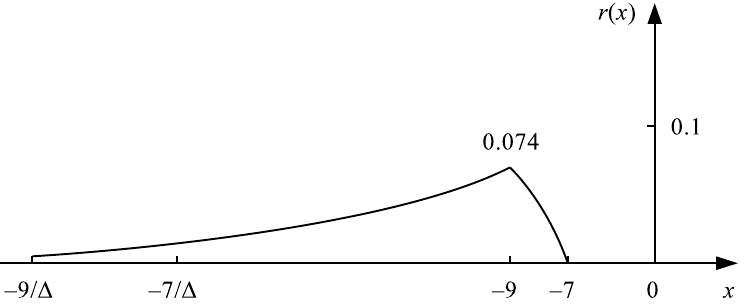
Figure 13. Robustness distribution r ( x ) of possible control values x < 0 of the system [ − 1,0,2 ] x = [ 7,9 ] .